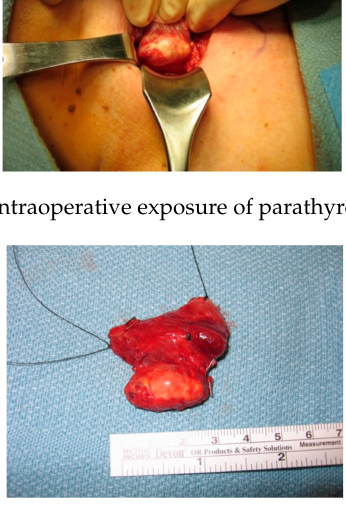
Figure 3. Operative specimen of parathyroid cancer with ipsilateral thyroid